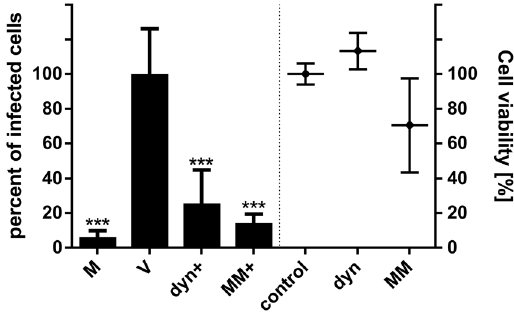
Figure 7. Inhibition of dynamin blocks HCoV-OC43 infection. HCT-8 cells were pre-treated with dynamin inhibitors, infected with HCoV-OC43 and analysed by means of flow cytometry 3 days p.i. The infection efficiency determined with flow cytometry is expressed as the percentage of HCoV-OC43 infected cells, compared to the untreated control, and is presented on the left side of the graph. Right part of the graph shows the cell viability, as determined with an XTT assay. dyn − 40 μ M dynasore; MM − 10 μ M MiTMAB; control – PBS treated cells; M − mock infected cells; V or + − HCoV-OC43 infected cells. The data is presented as the mean of a triplicate for each sample ± SD. To determine the significance of differences between compared groups, Single-Factor Analysis of Variance (ANOVA) was applied. *** P values < 0.05 were considered